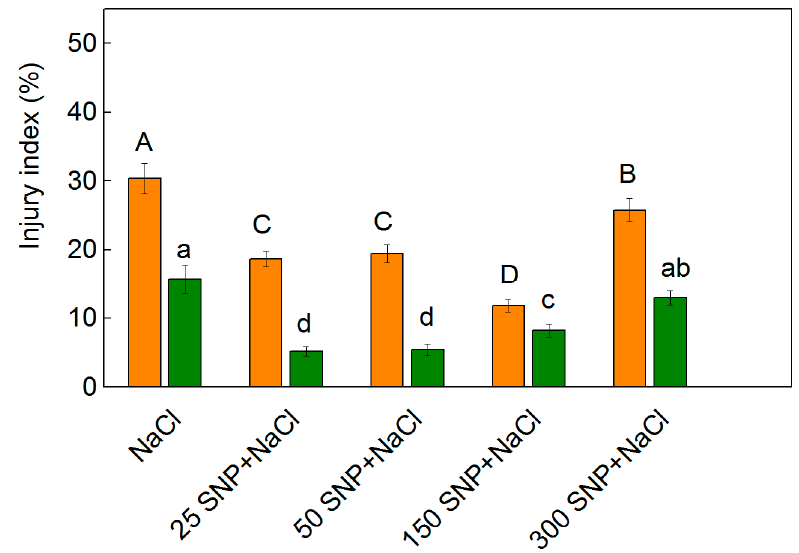
Figure 4. Injury index of leaves from the two sorghum varieties (Albanus—orange bars and Shamal— green bars) treated with 150 mM NaCl alone and after spraying with different concentrations of SNP (0–300 µ M). Mean values ( ± SE) were calculated from eight independent measurements. The significant differences among treatments at p < 0.05 are indicated by different letters (uppercase for Albanus and lowercase for Shamal).